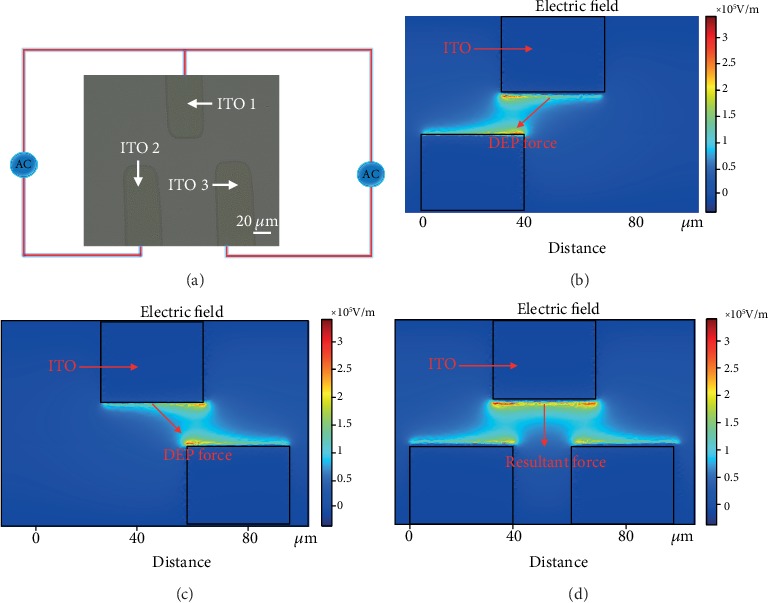
Simulation of the electric field gradient between the ITO electrodes and the direction of the DEP force.